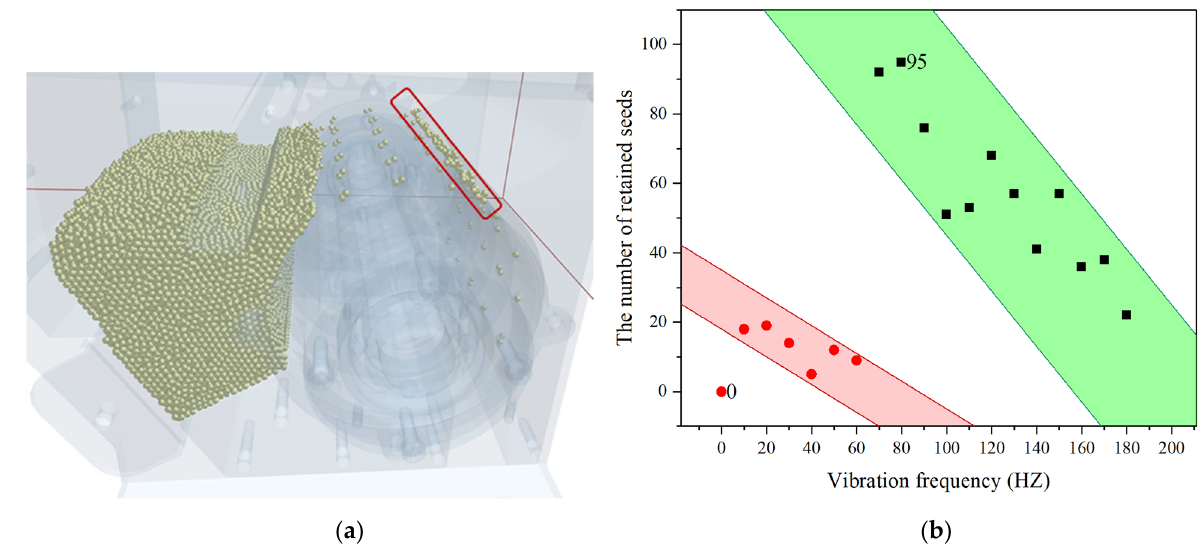
Figure 9. ( a ) Sketch map of retained seeds, and ( b ) effect of vibration on the number of retained seeds.